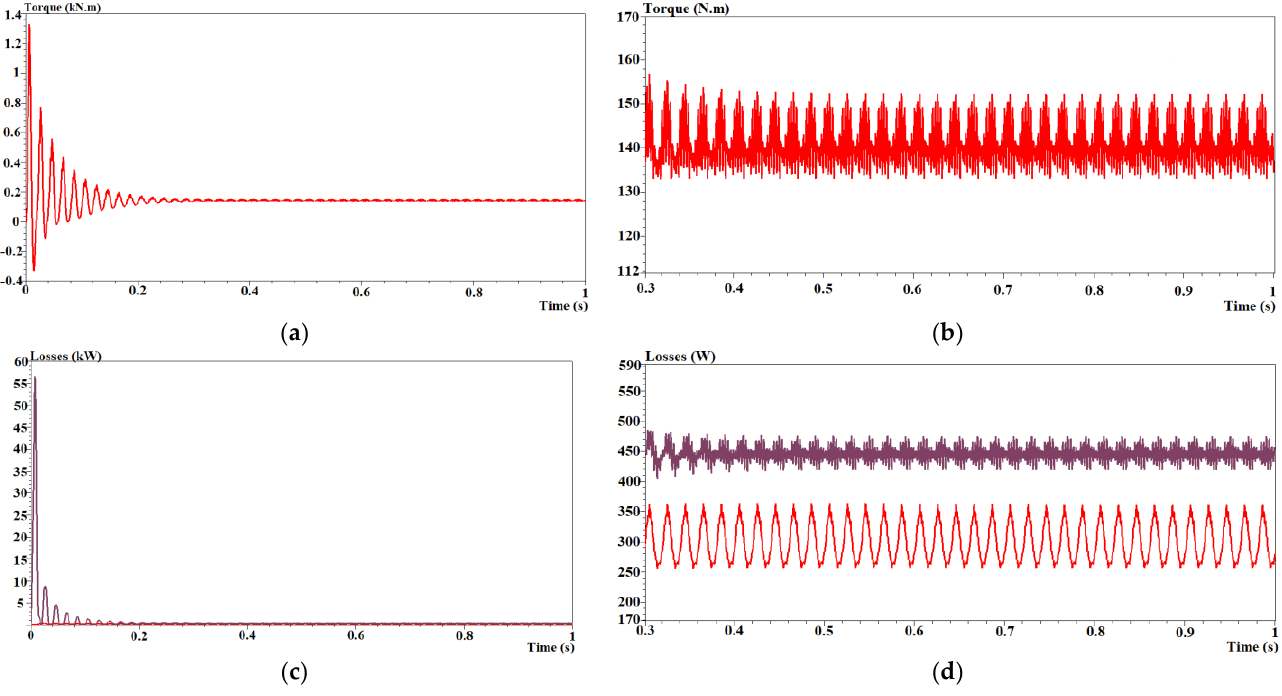
Figure 5. The results of FEAs of the fine − tuning: ( a ) T e ; ( b ) Zoomed T e ; ( c ) P cop and P fe ; ( d ) Zoomed P cop (shown with purple) and P fe (shown with red)